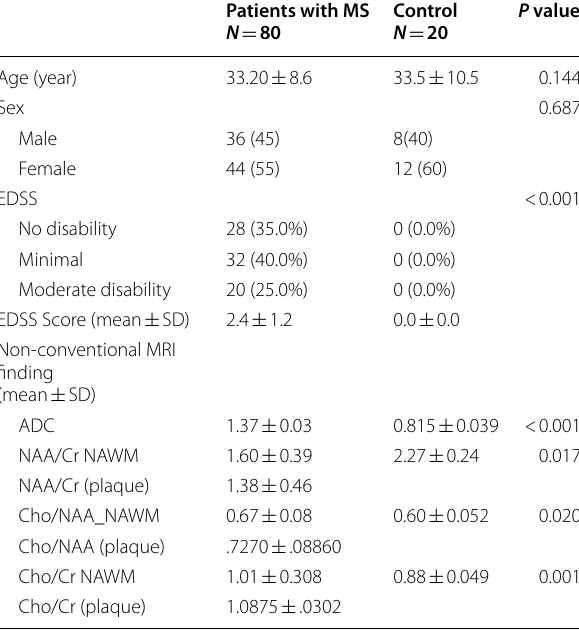
Table 1 The natural history of multiple sclerosis: a Table 2 Comparison between patients with MS and healthy controls